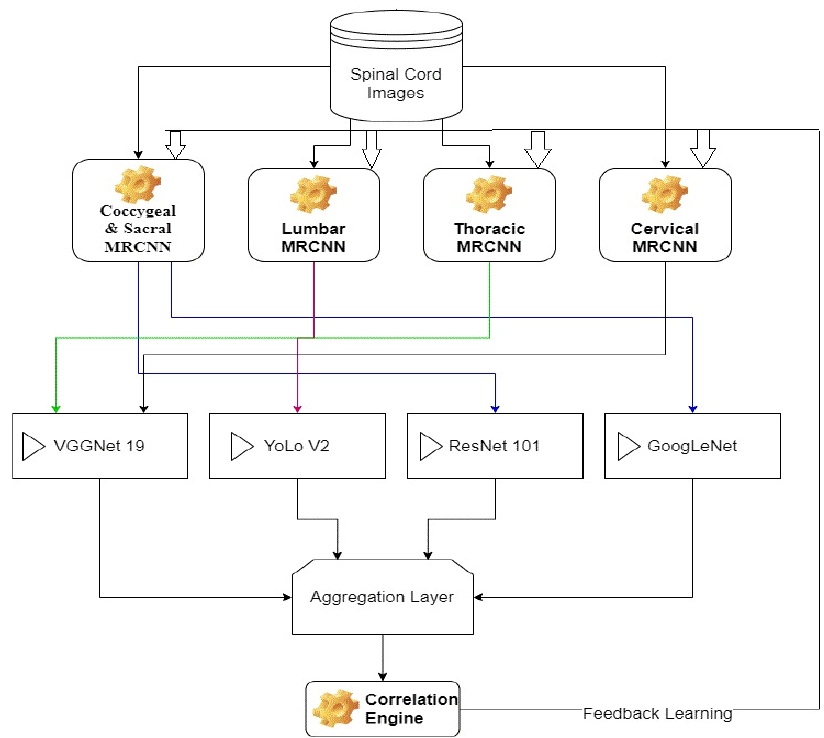
Figure 2. Overall fl ow of the proposed model .